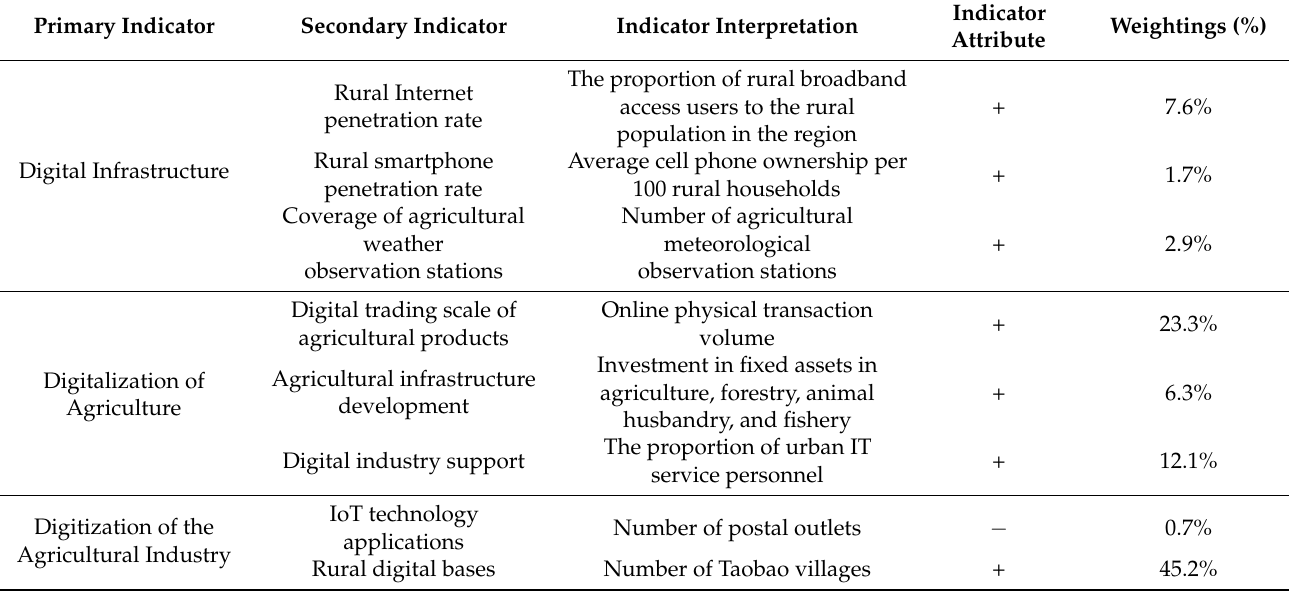
Table 1. Digital economy development level indicator